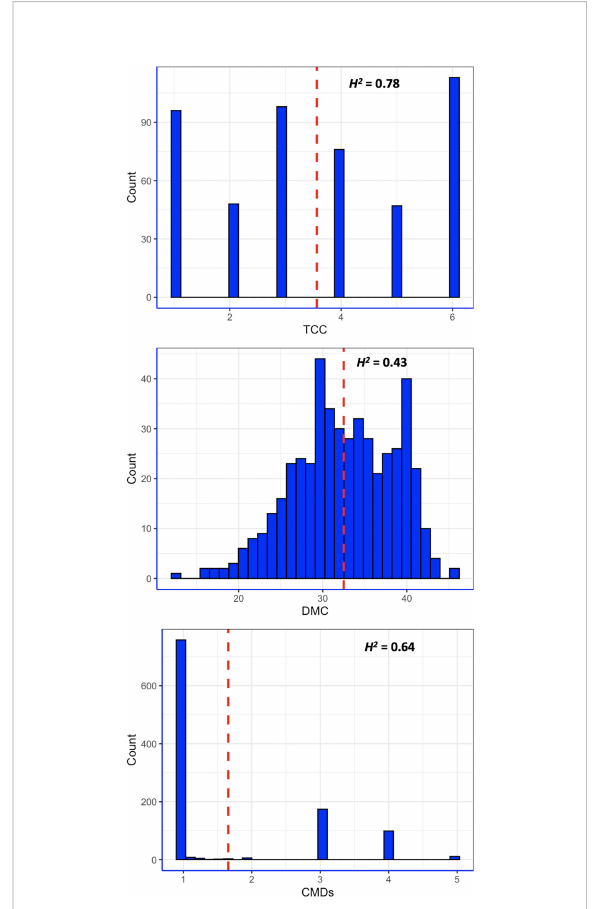
FIGURE 1 Distribution of phenotypic values of three traits measured in this study. CMDs = severity of cassava mosaic disease; DMC = dry matter content; TCC = total carotenoids content; H 2 = broad- sense heritability; red dashed line is the mean value for each